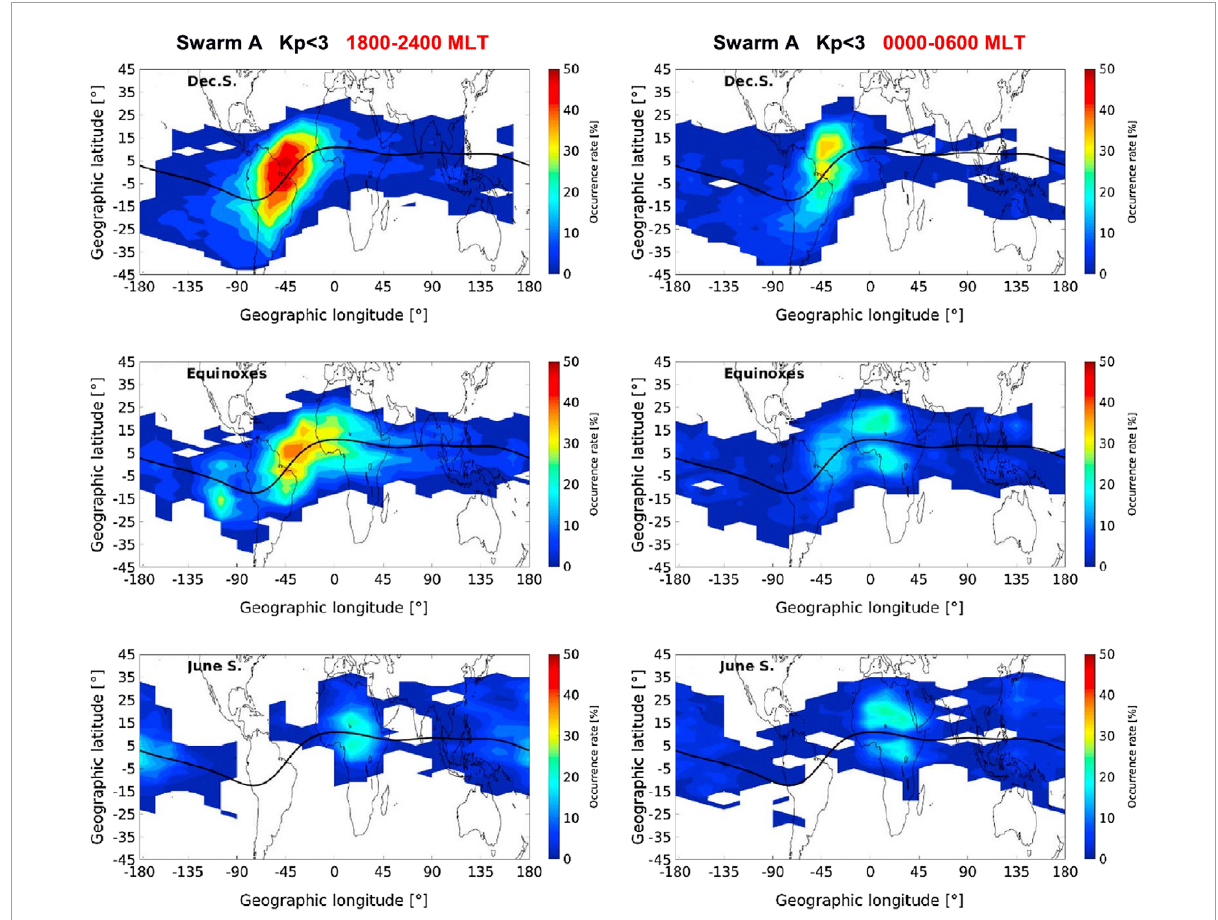
FIGURE 1 Occurrence rate of equatorial plasma depletions as a function of longitude and latitude for (left) post-sunset sector and (right) post-midnight sector (from Wan et al.,